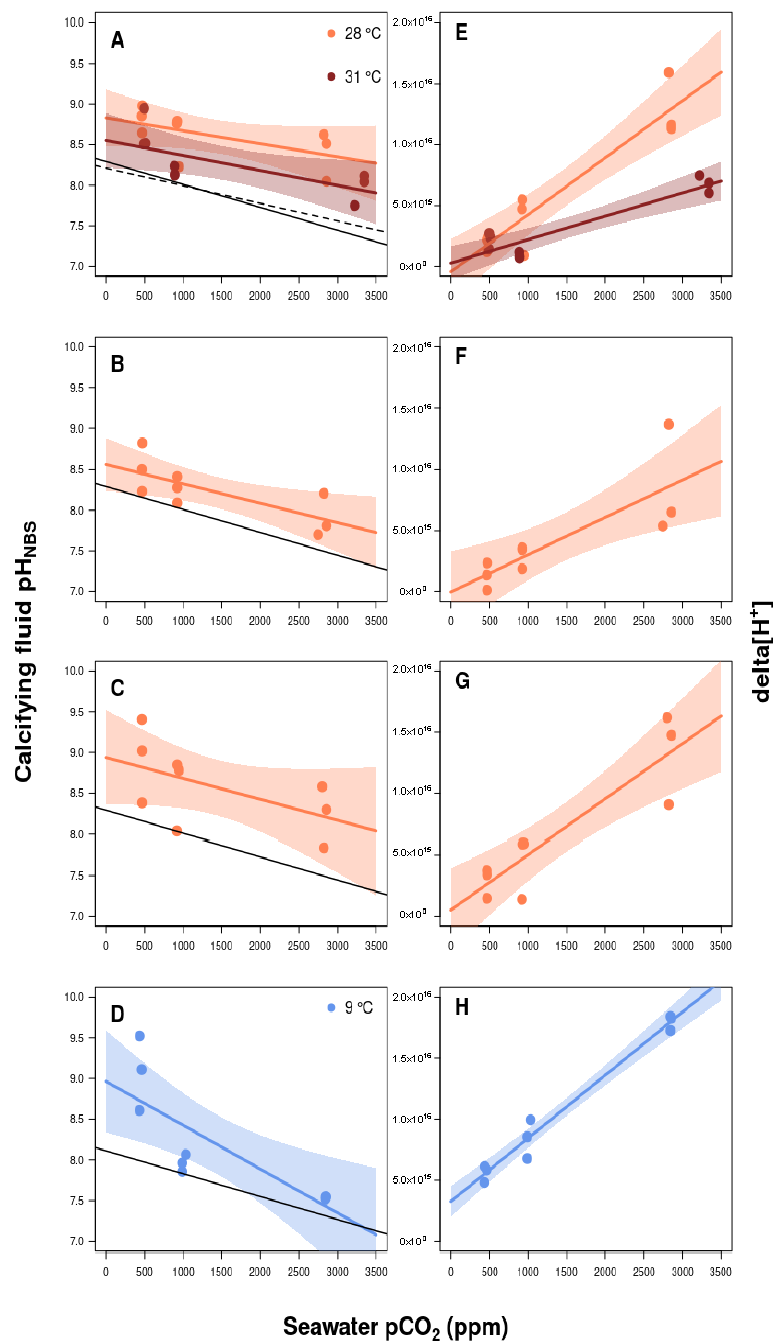
Figure 4. The effect of seawater pCO 2 on calcifying fluid pH (n = 3 individuals per treatment; panels ( A – D )) and ∆ [H + ] (panels ( E – H )) for three species of tropical corals (( A , E ) = S. pistillata ; ( B , F ) = S. hystrix , and ( C , G ) = P. damicornis ) and one species of cold-water coral ( L. pertusa ; ( D , H )). The impact of elevated temperature on the response of S. pistillata to increasing pCO 2 is also shown (panels ( A ) and ( E )). Increasing pCO 2 was significantly associated with declining calcifying fluid pH and increasing Δ[H + ] for all four coral species. The calcifying fluid pH of S. pistillata decreased significantly in response to a 3 °C increase in temperature, and Δ[H + ] significantly responded to an interaction between increased pCO 2 and increased temperature. Shaded boundaries represent 95% confidence intervals. Solid black lines represent seawater pH under control temperature; dashed black line represents seawater pH under high temperature.